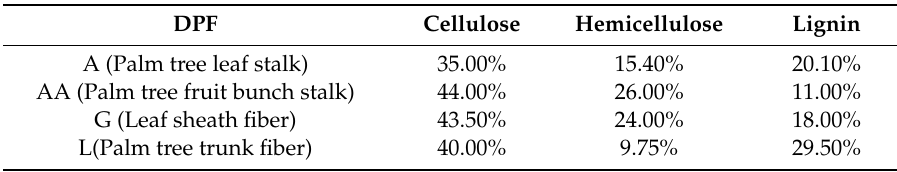
Table 2. Chemical composition of DPF used in this study.